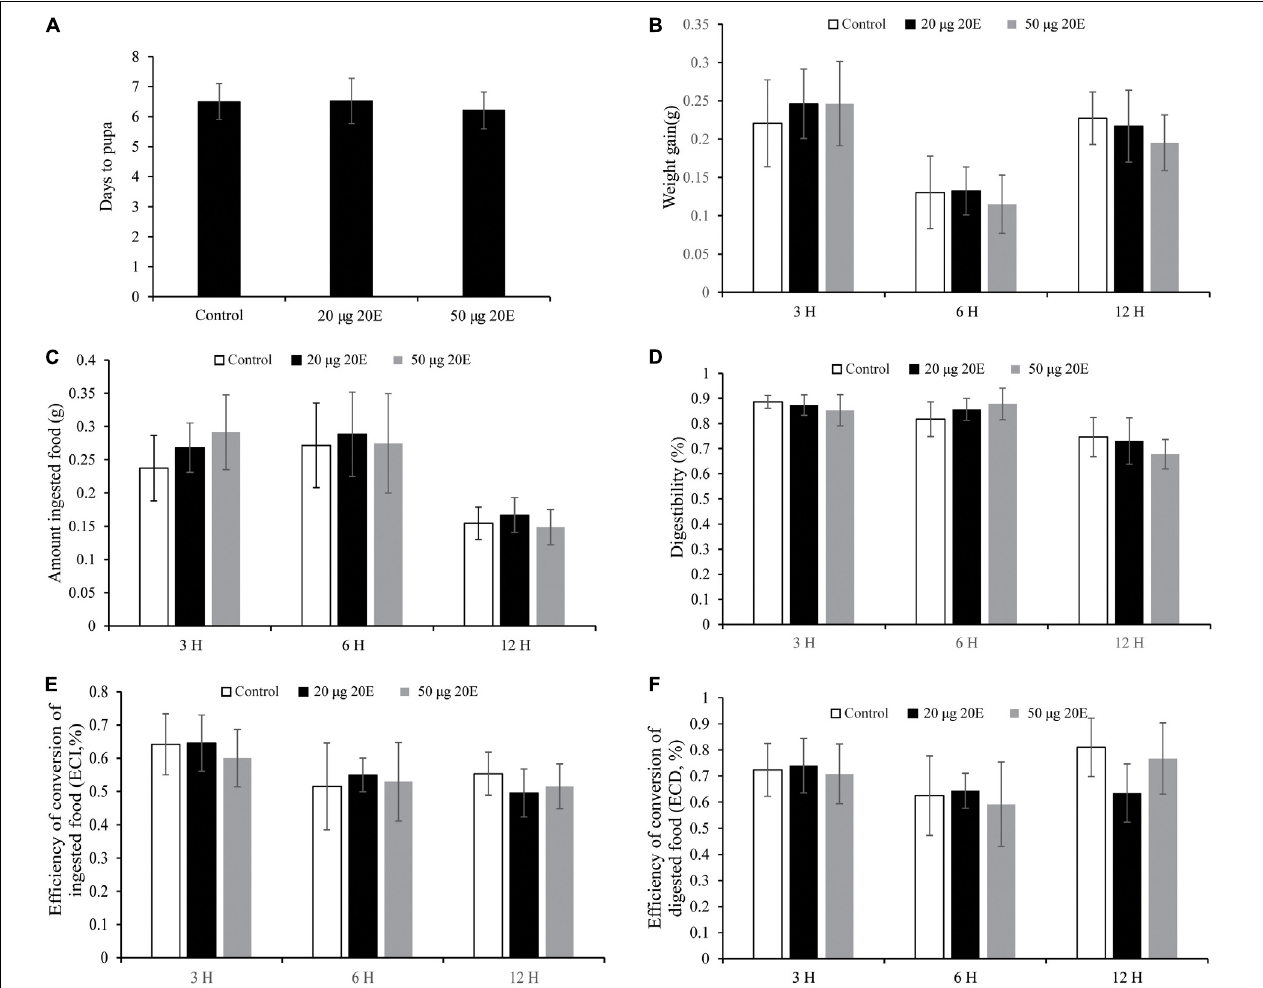
FIGURE 1 | Effects of the ingested 20E on the growth and development of the cotton bollworm larvae. (A) The time to pupation of the larvae reared on food treated with control or different concentrations of 20E. (B) The weight gain of the larvae reared on food treated with control or 20E. (C) The average amount of ingested food by the control or 20E treated larvae. (D) The digestibility of the larvae treated with control or 20E; (E) The efficiency of conversion of ingested food (ECI) of the larvae treated with control or 20E. (F) The efficiency of conversion of digested food (ECD) of the larvae treated with control or 20E. Mann–Whitney U test was used to do the statistic